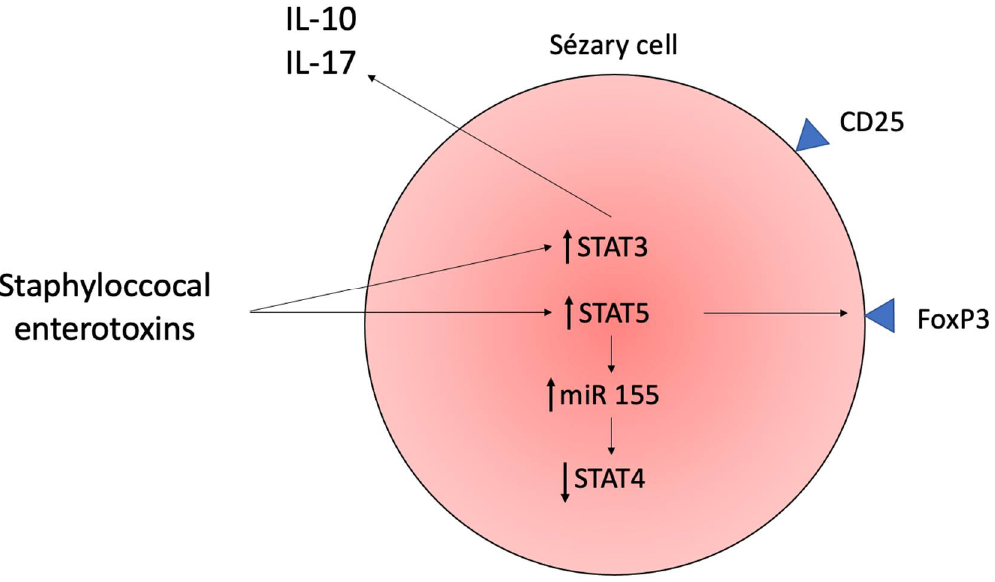
Figure 10. The interaction of Staphylococcus aureus enterotoxins in Sézary cells. The SE superantigen increases STAT3 and STAT5 function. The STAT3 pathway leads to increased production of IL-10 and IL-17. The IL-10 prevents DCs from maturating and favors the expression of the Treg phenotype in Sézary cells. The STAT5 increases production of miR-155 that inhibits the Th1 STAT4 pathway.